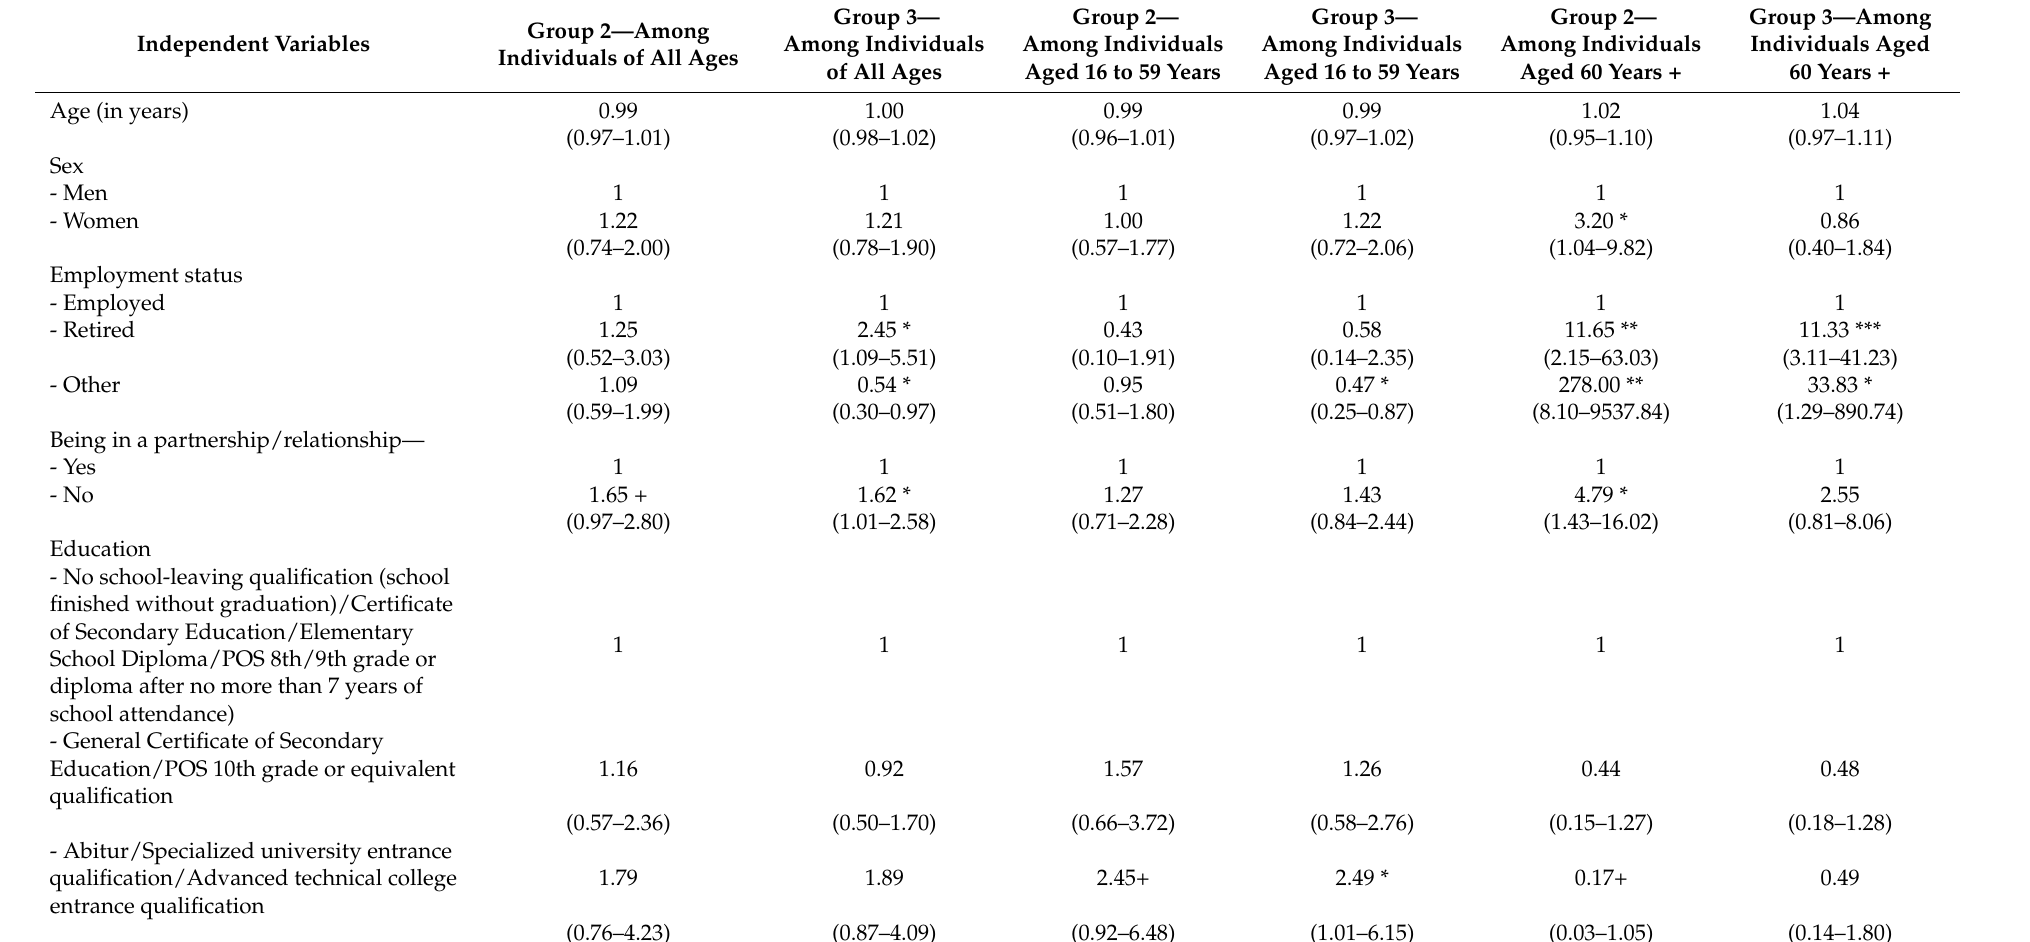
Table 2. Determinants of vaccination against COVID-19. Results of multinomial logistic